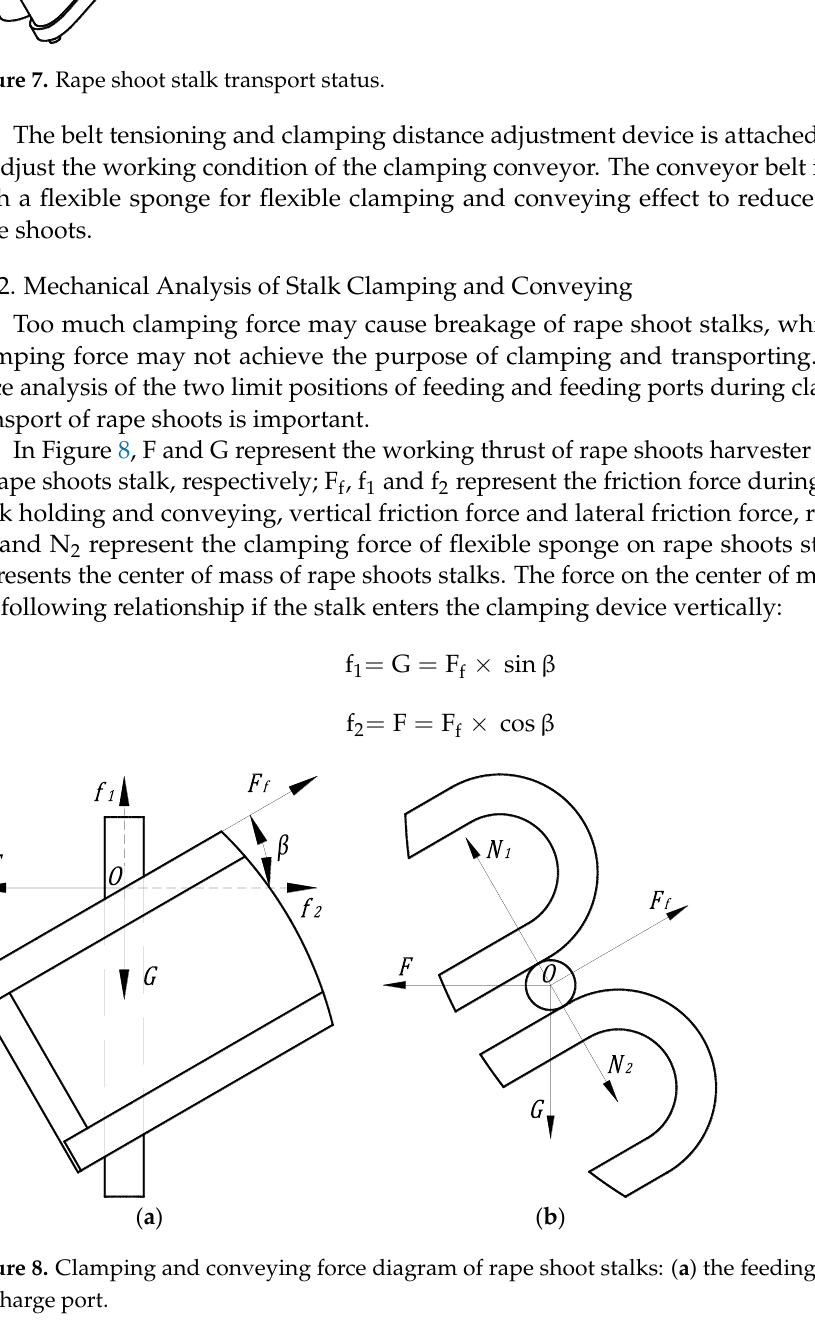
Figure 9. Schematic of the cross-sectional forces of rape shoot stalks. The gravity of the stalk starts to act on the flexible sponge of the lower belt when the rape shoot stalks change from vertical to horizontal position. As a result, the upward clamping force of the flexible sponge on the rape shoots gradually increases compared with the downward clamping force of the flexible sponge on the plants. The required clamping force of rape shoots at the feeding port is the maximum value of the clamping and conveying stage. The subsequent clamping and conveying process can ensure that the rape shoots do not slip in any direction and smoothly complete the clamping and con- veying operation if the clamping force of the rape shoots at the feeding port ensures that the plants do not slip in any direction. Herein, the rape shoots vertically clamped in the feed opening were used for analysis. The clamping force N 1 and N 2 of flexible sponge on the stalk is a pair of equilibrium forces. The clamping force on the rape shoots stalk should satisfy the following equation to en- sure that the rape shoots do not slip during the clamping and conveying process and avoid damage to plants: